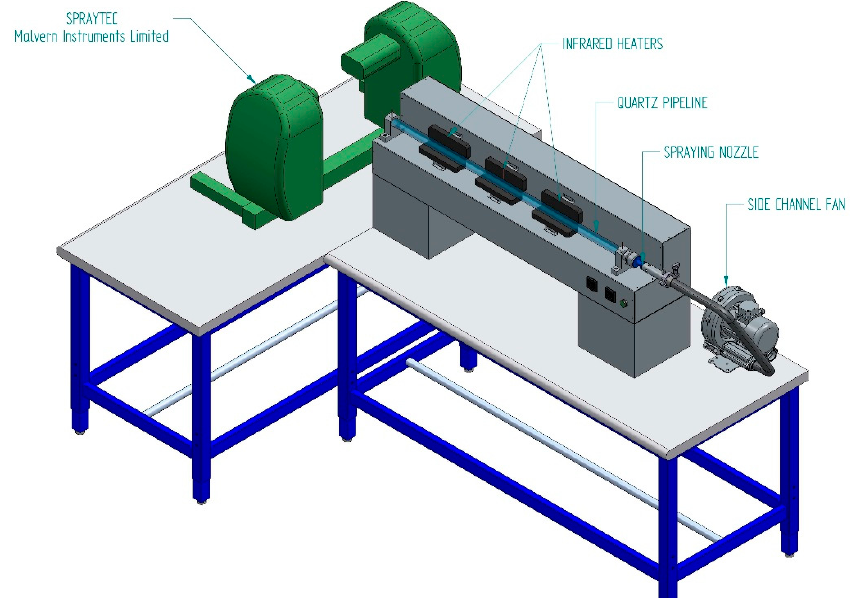
Figure 1. Test stand.